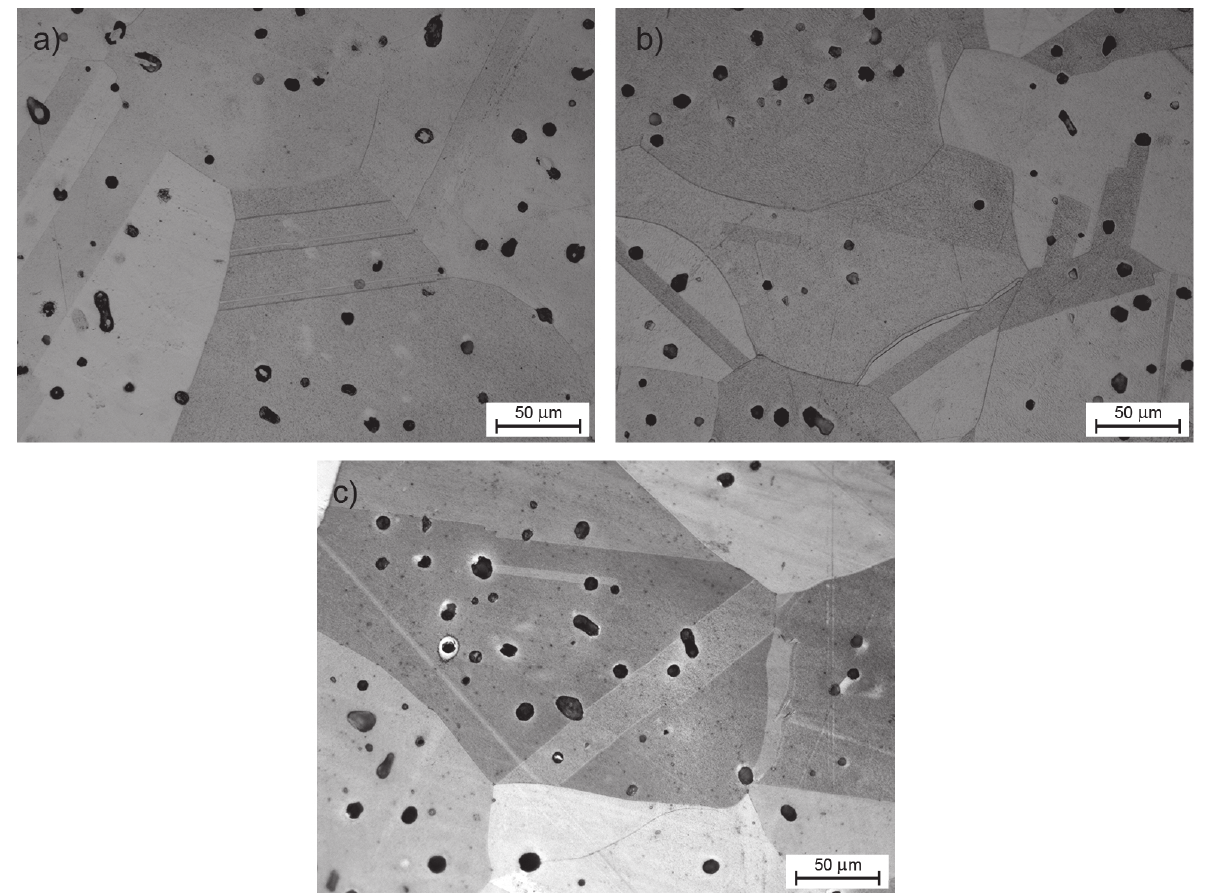
Figure 10. Micrographs of optimal samples sintered at 1325 °C for a holding time of 12 h under atmosphere of ( a ) N 2 -5%H 2 , ( b ) N 2 -10%H 2 -0.1%CH 4 , and ( c ) low vacuum.